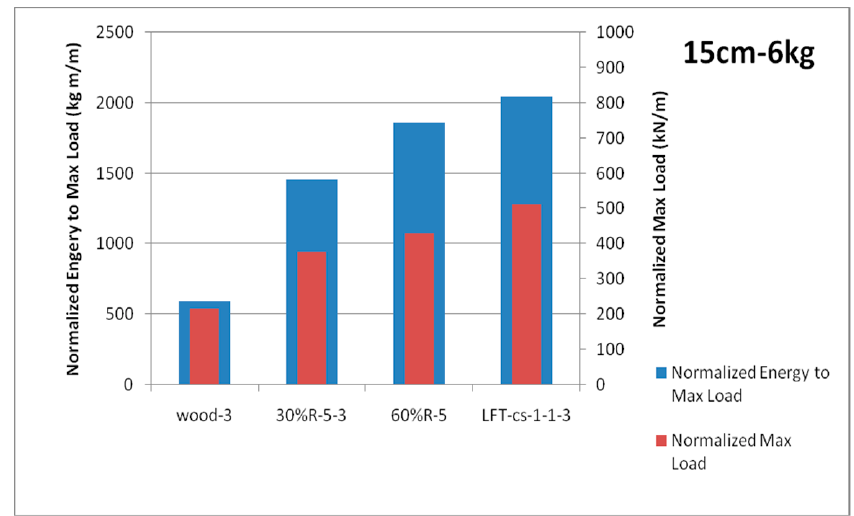
Figure 17. Normalized impact energy and normalized load of 6 kg impact mass at 15 cm height—for plywood, 30 wt% scrap, 60 wt% GF-PP recyclate composite, and conventional LFT. The results show that 60 wt% scrap material is closer in energy absorption to LFT. Wood behaves poorly.